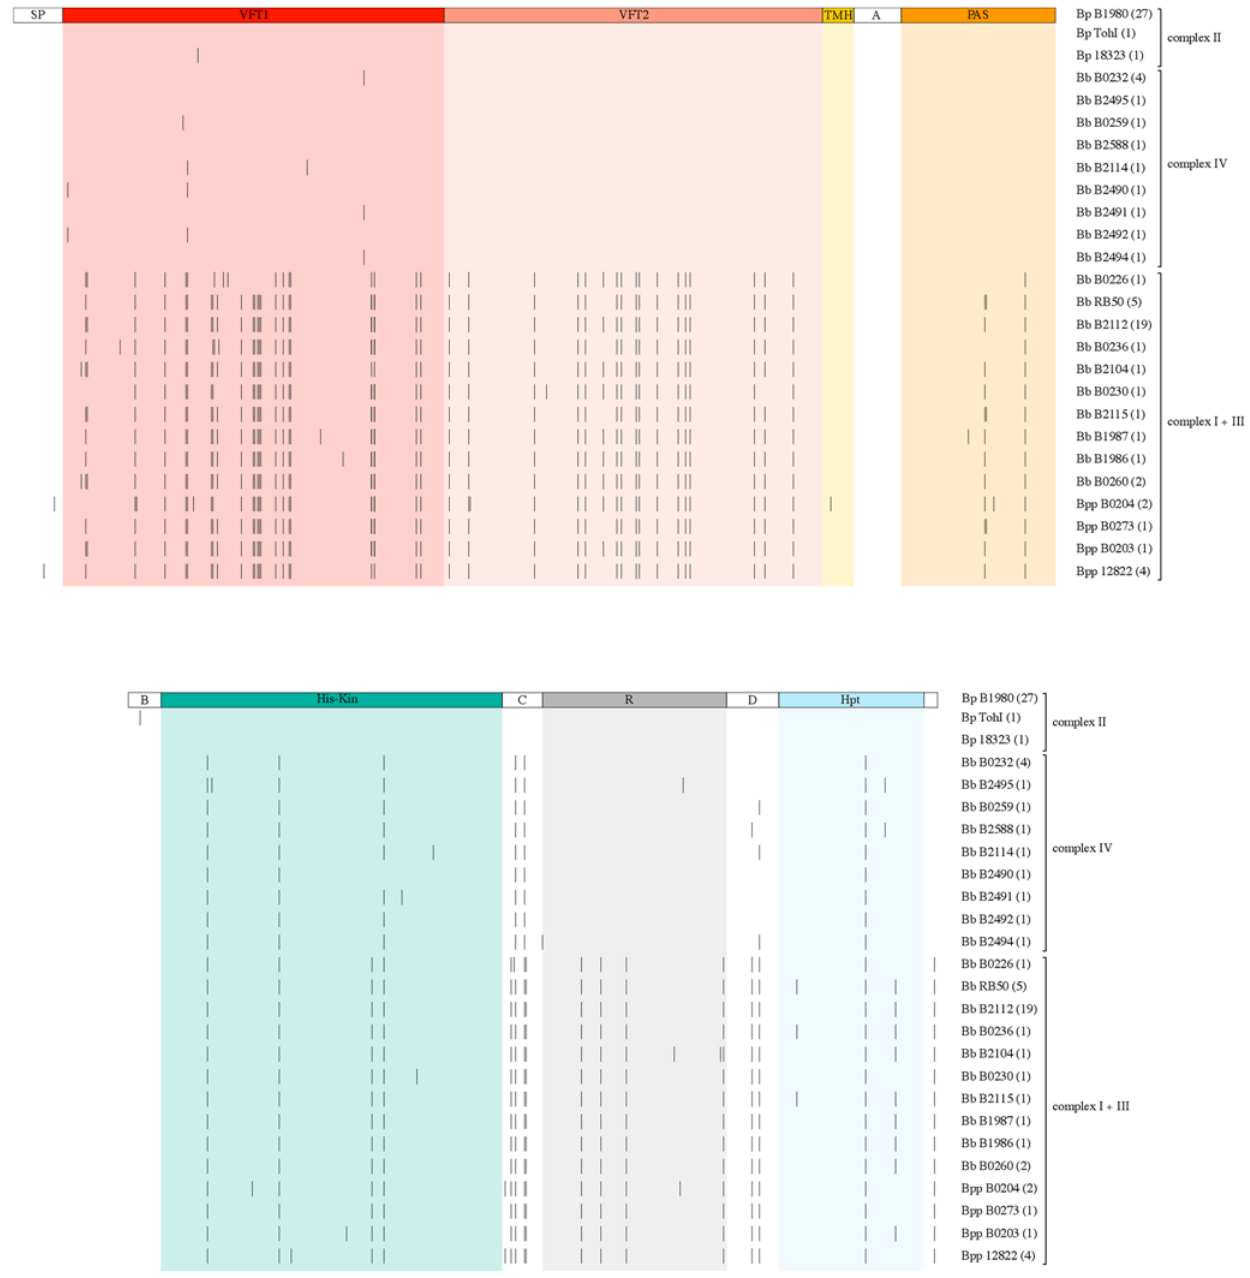
Figure 2. Schematic representation of BvgS variability at the amino acid level. The complexes I + III, II and IV are defined as in Fig. 1. The various domains of BvgS drawn to scale are boxed in colors. The top line represents the prototype BvgS of all B. pertussis isolates but Tohama I and 18323. Each line below represents a distinct BvgS sequence, with each substitution relative to the reference sequence shown as a small vertical bar at the corresponding position in the protein. The same substitution is systematically found at any given position. Some of the BvgS variants displayed represent several isolates, the number of which is given in parentheses. SP represents the signal peptide, TMH the transmembrane helix, R the receiver domain, and A, B, C and D the four linkers connecting the domains (see text).